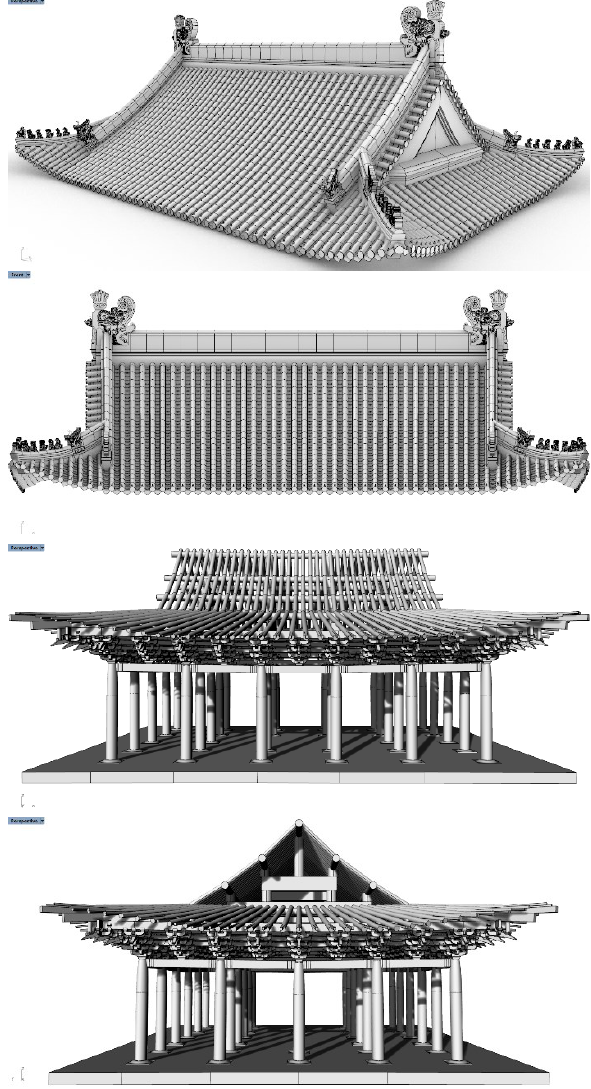
Figure 10. Two plugins of algorithm